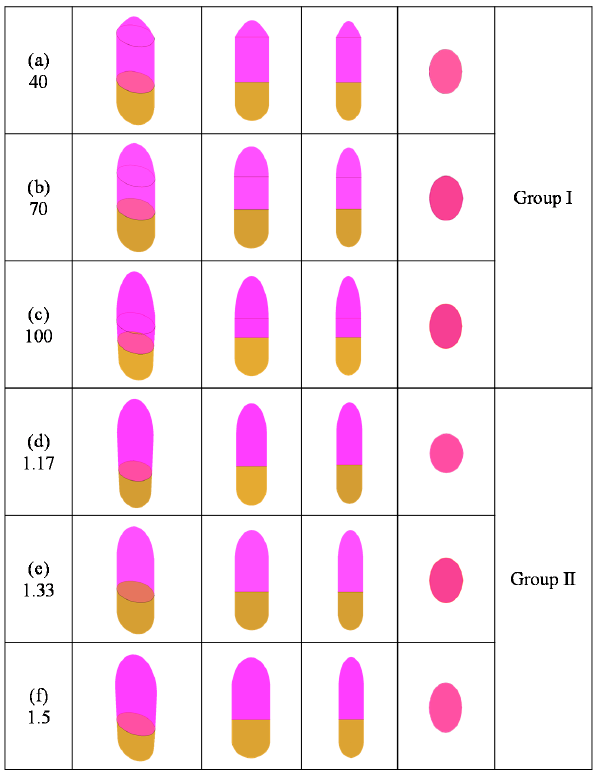
Figure 6. Design scheme of two groups of six cavern shapes. Group Ⅰ has three top structures of 40 m ( a ), 70 m ( b ) and 100 m ( c ). Group Ⅱ shows three types of transverse section with R LS of 1.17 ( d ), 1.3 ( e ) and 1.5 ( f ).